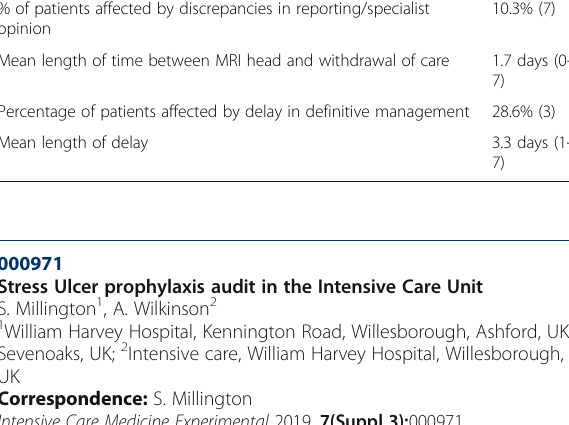
Table 1 (abstract 000957). Results of patients with image reporting discrepancies % of patients affected by discrepancies in reporting/specialist opinion Mean length of time between MRI head and withdrawal of care 1.7 days (0- Percentage of patients affected by delay in definitive management 28.6% (3) Mean length of